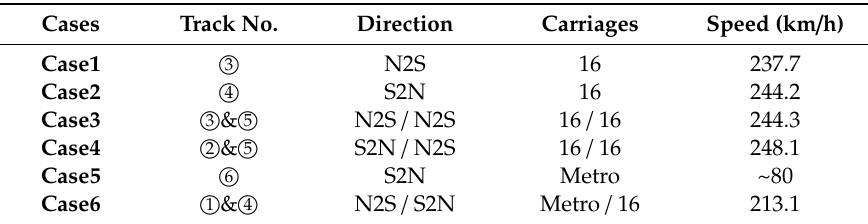
Figure 7. ( a ) Range profile of view S2a: the vertical dotted gray lines indicate the 16 selected radar bins (number 57, 60, 61, 65, 69, 74, 78, 81, 84, 90, 93, 96, 102, 105, 112 and 114) for estimating the deck displacement; ( b ) scheme of the radar geometry using the lidar point cloud. The red line indicates the radar bin (number 84) and the corresponding position of the hydrostatic leveling, in the middle of the 192-m span. Table 2. Loading cases of view